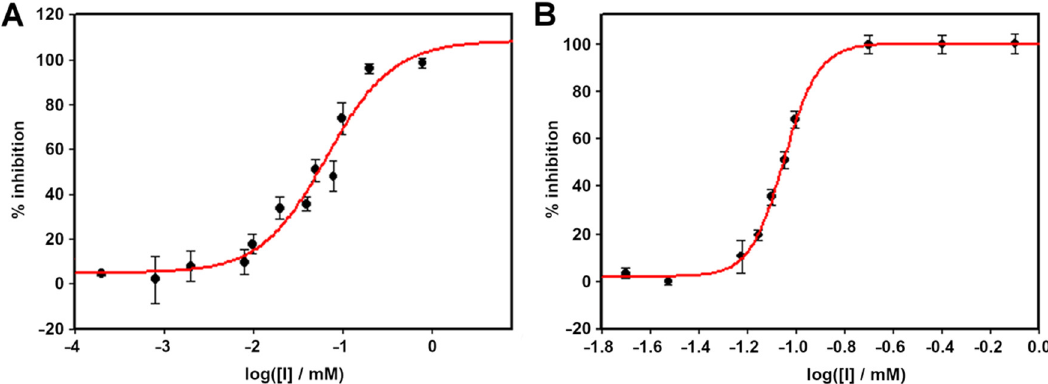
Figure 6. Inhibition of ( A ) Slt35 and ( B ) lysozyme by thionine acetate. For Slt35, 7 μ M enzyme and 0.6 mg mL − 1 cell suspension were used at 37 °C in 25 mM Tris-maleate buffer (pH 5.8) containing 10 mM CaCl 2 . For lysozyme, 0.1 μ M enzyme and 0.6 mg mL − 1 cell suspension were used at 37 °C in 25 mM Tris-maleate buffer (pH 6.0) containing 100 mM KCl.